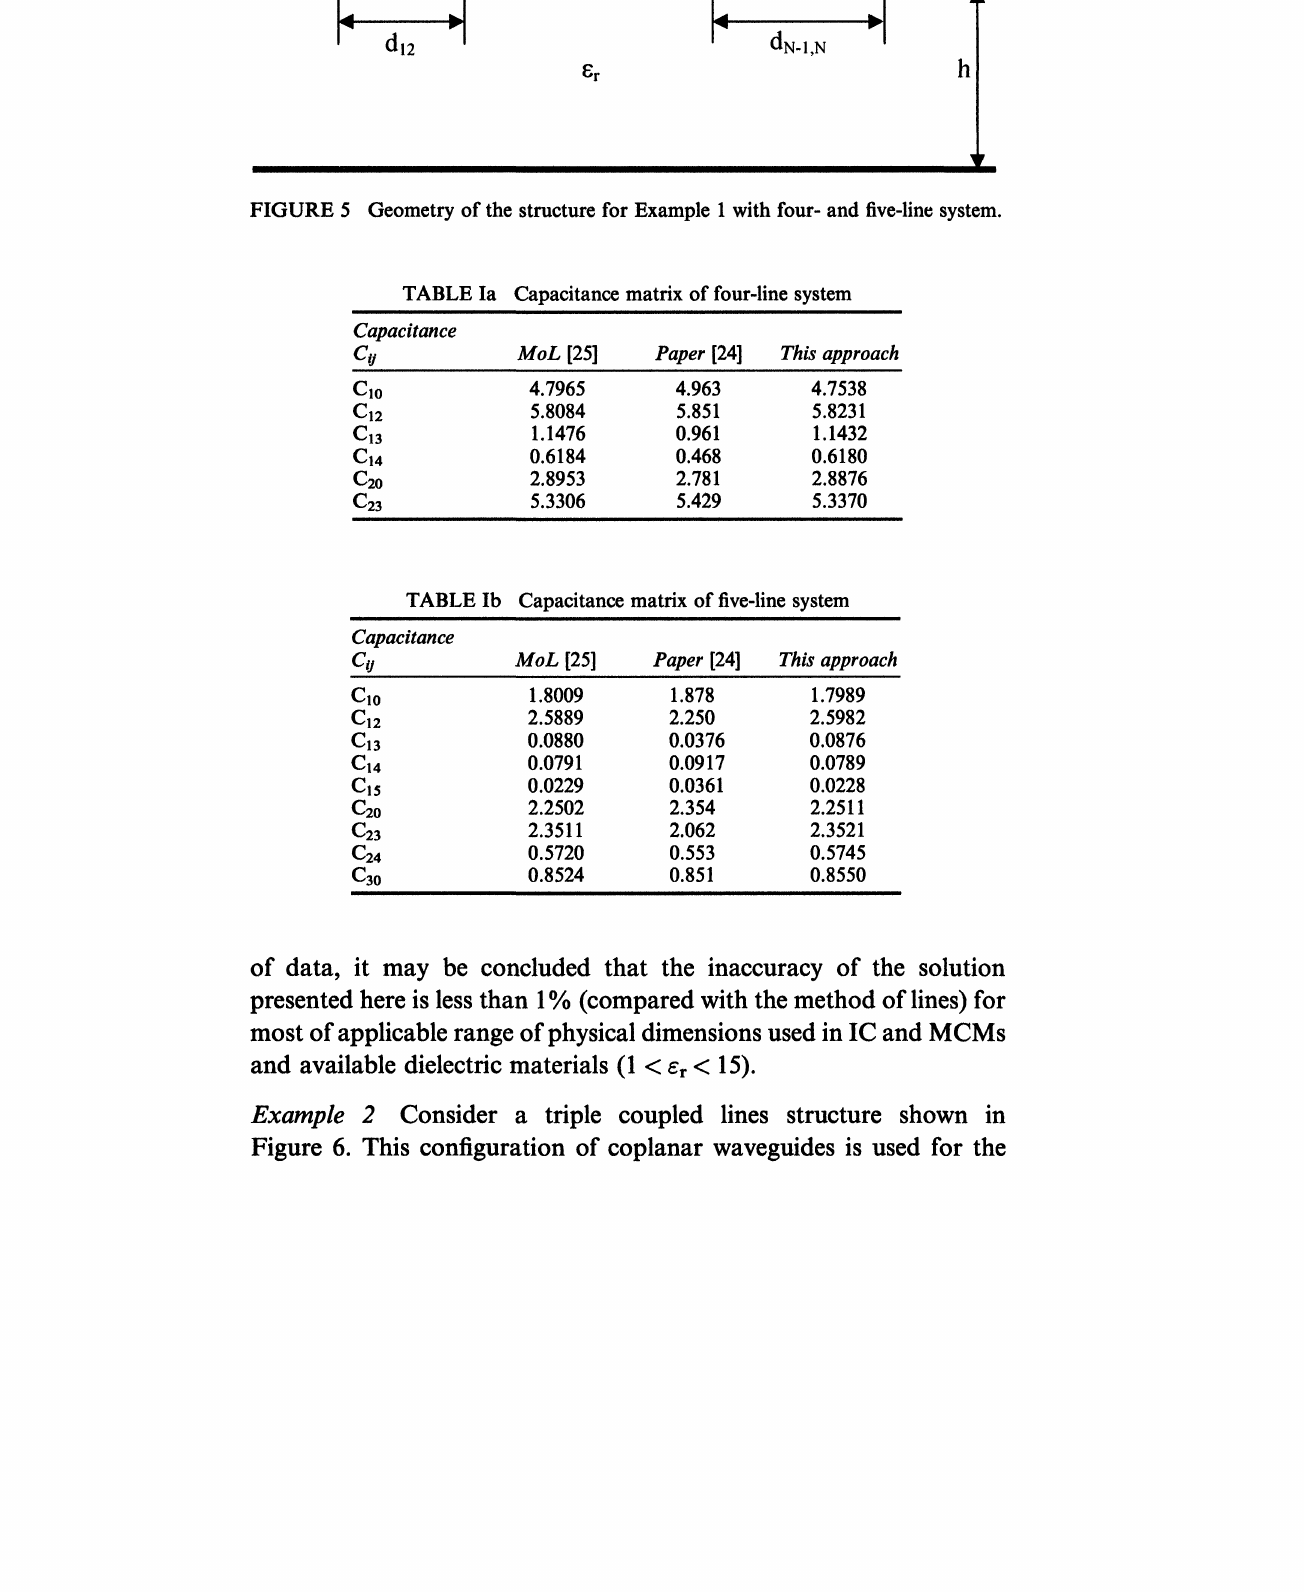
FIGURE 5 Geometry of the structure for Example with four- and five-line system. TABLE Ia Capacitance matrix of four-line system